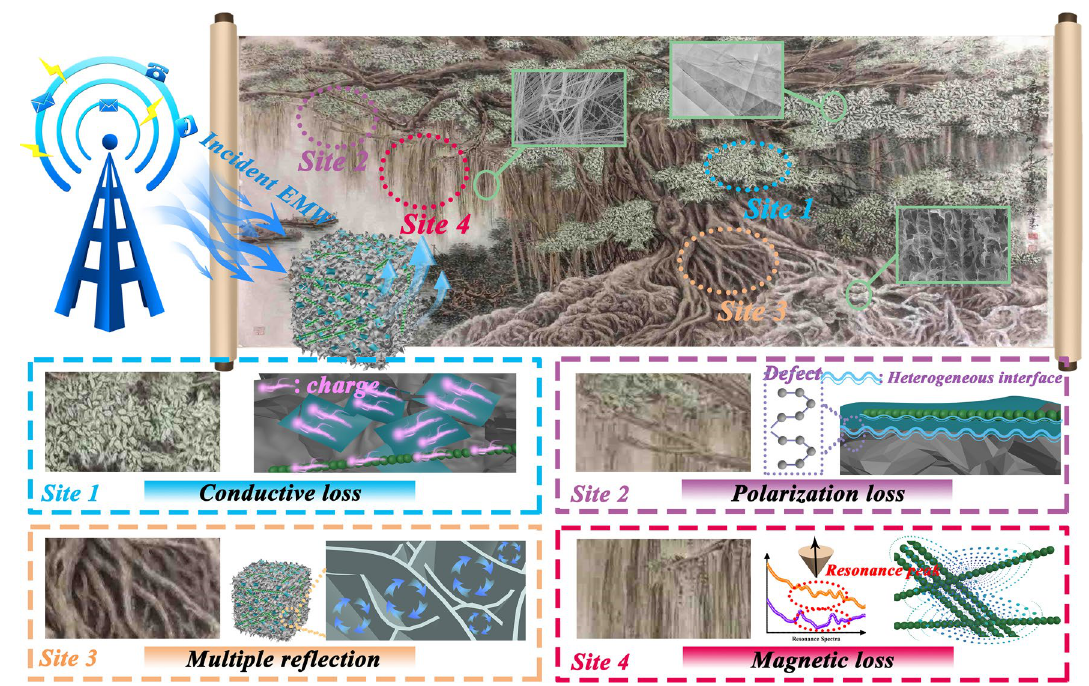
Fig. 5 Schematic illustration of EMW absorption mechanisms for the BCMNA with different strategies: site 1) progressive conductive loss network; site 2) multicomponent-induced polarization loss; site 3) porous-derived multiple scattering; site 4) macroscopic scale-enhanced elec- tromagnetic cooperation; and the insert ink painting derive from Chinese painter Yunlong Feng’s “Banyan